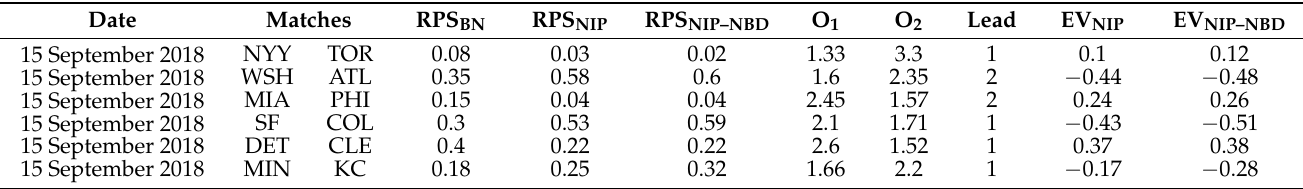
Table 3. Comparison of rank probability scores (RPSs) and expected values (EVs) subject to basic normalization (BN), new implied probability (NIP), and NIP–negative binomial distribution (NIP–NBD) for 15 September 2018.